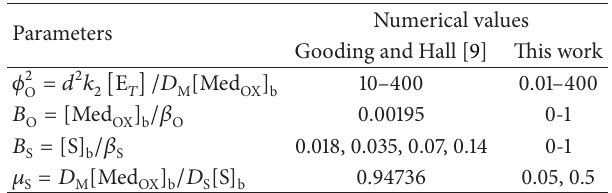
Table 2: Possible numerical values for dimensionless parameters used by Gooding and Hall [9] and in this work.